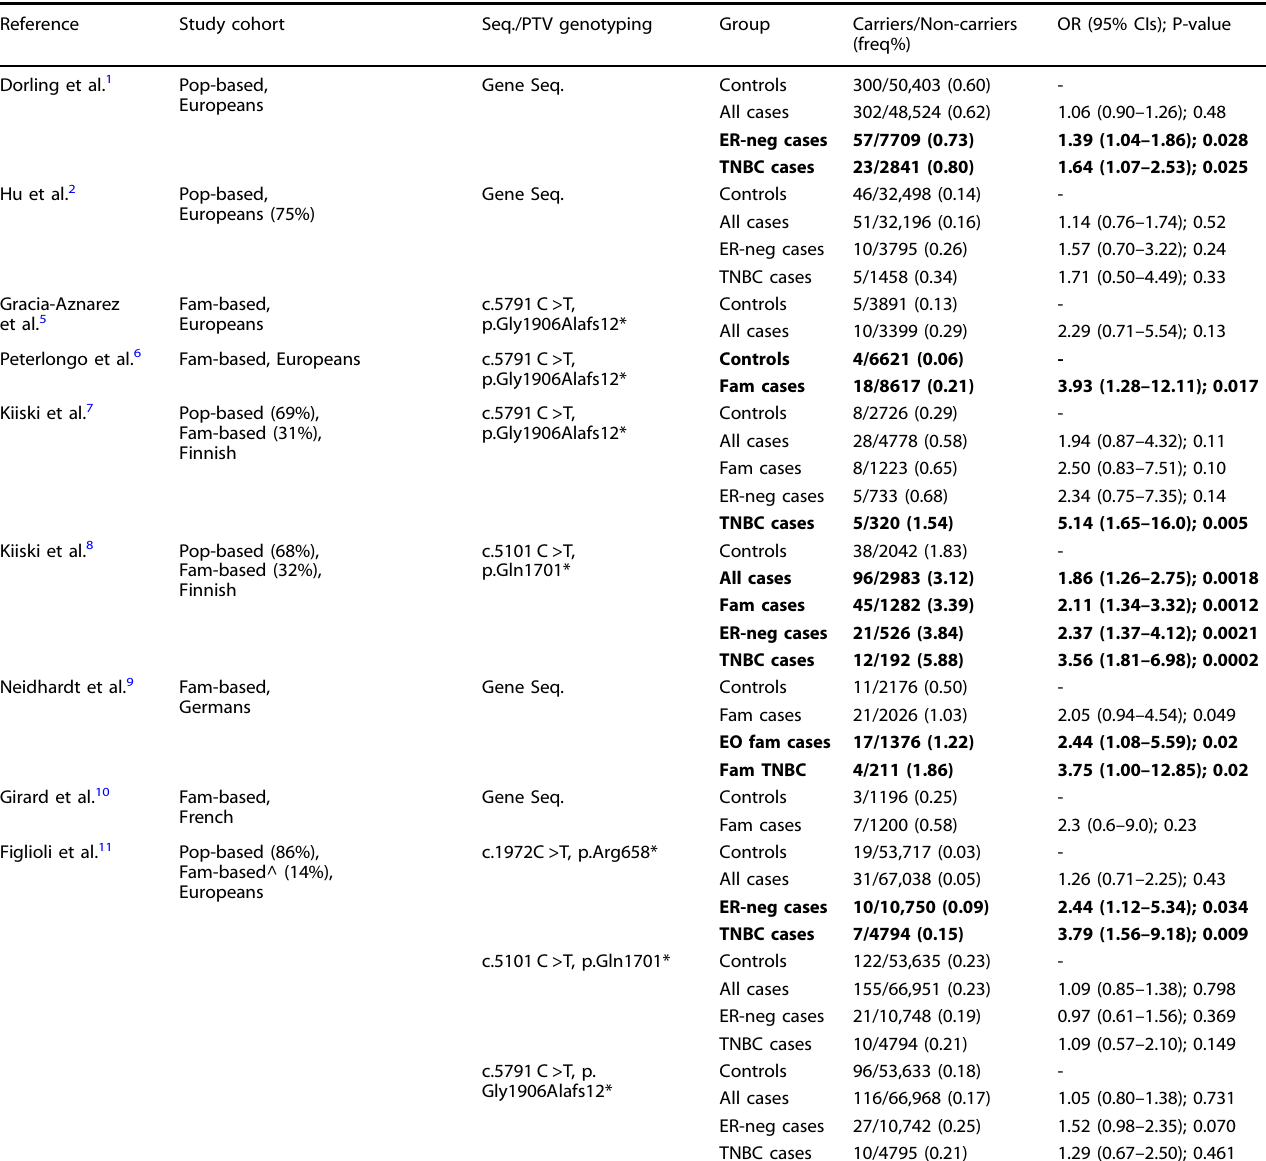
Table 1. Results from association studies conducted in European cases and controls on FANCM PTVs and breast cancer risk ordered as mentioned in the